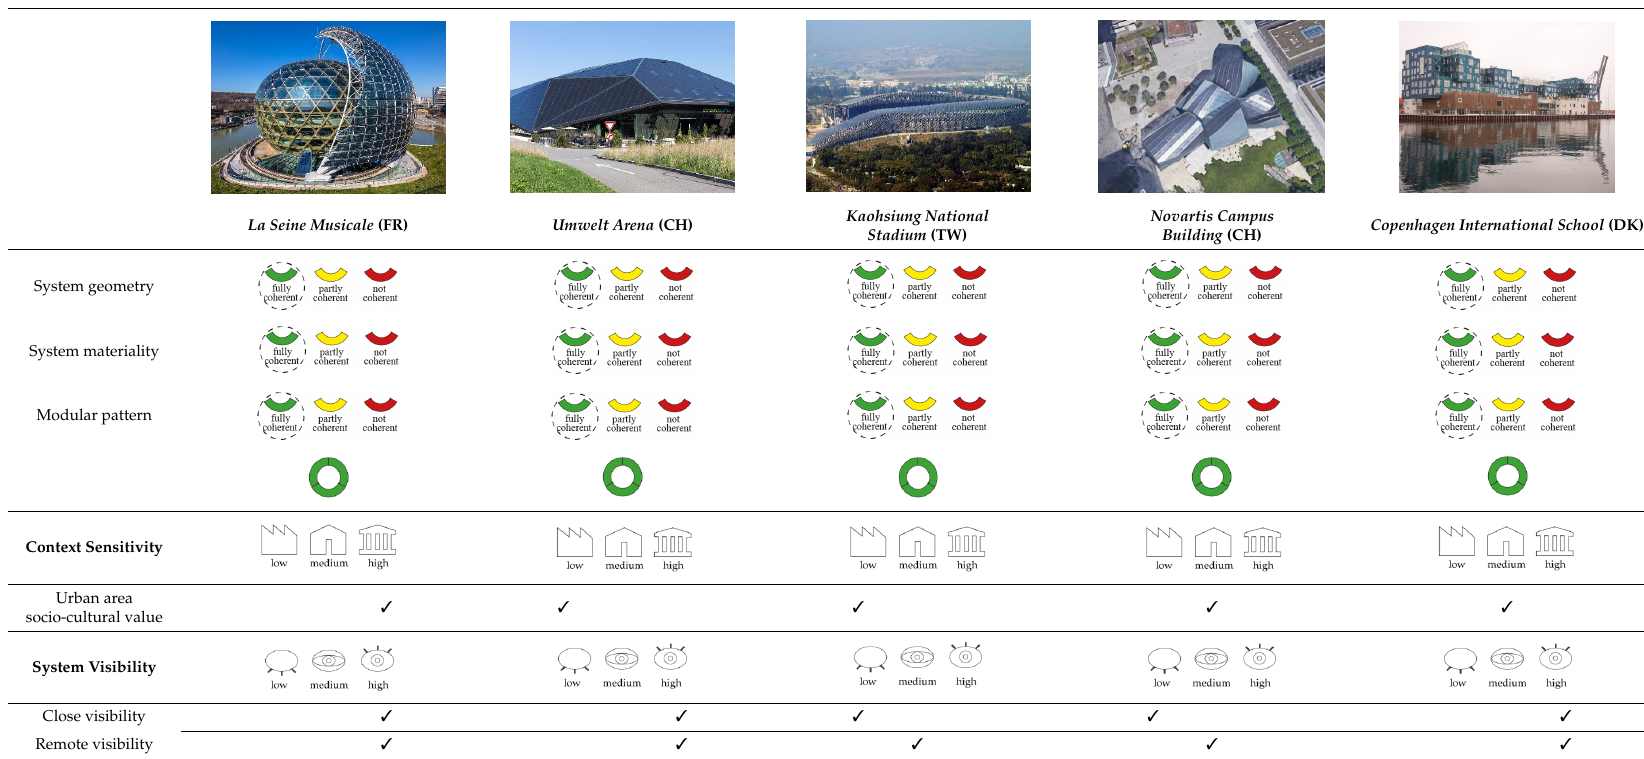
Table 5. Architectural integration quality, context sensitivity and system visibility of the landmark buildings (second part).